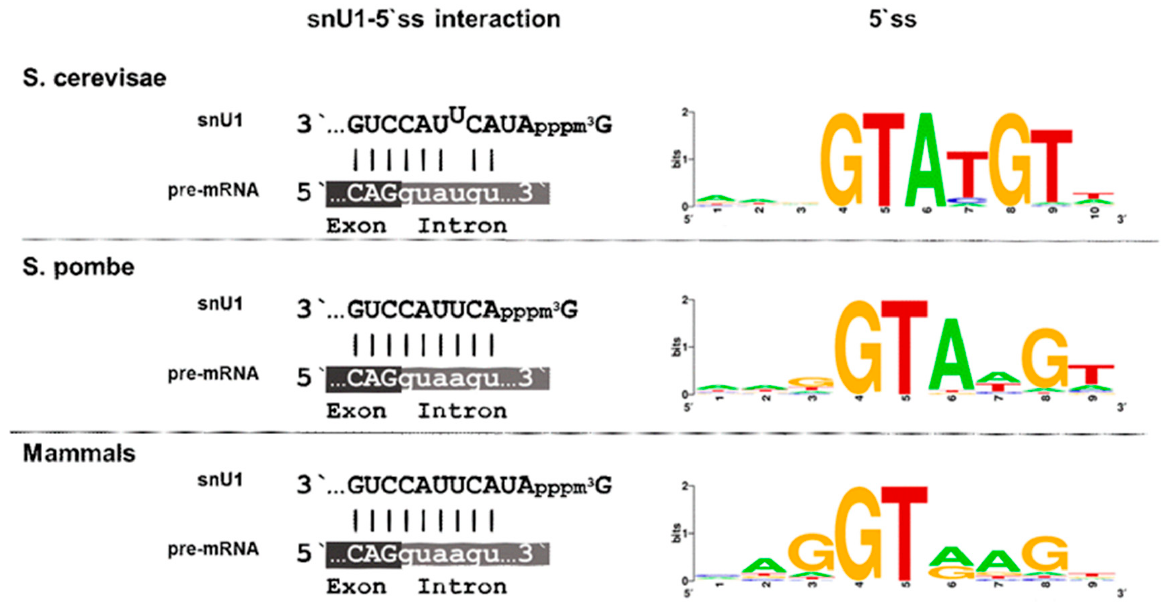
Figure 3. snU1-5 ′ ss interaction. Nucleotide based interactions of snU1 with the 5 ′ ss ( left ) and consensus sequence of the 5 ′ ss ( right ) in S. cerevisiae , S. pombe , and mammals. Sequence logos were generated by WebLogo (Version 2.8.2) and sequences of the 5 ′ ss were derived from: S. cerevisiae [13] , S. pombe [98], and mammals [99] .